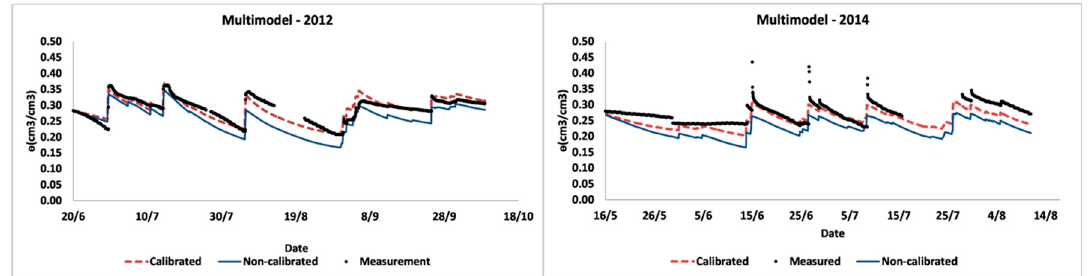
Figure 3. Ensemble modeling of soil moisture based on Curve number, Green and Ampt and Philip equations.